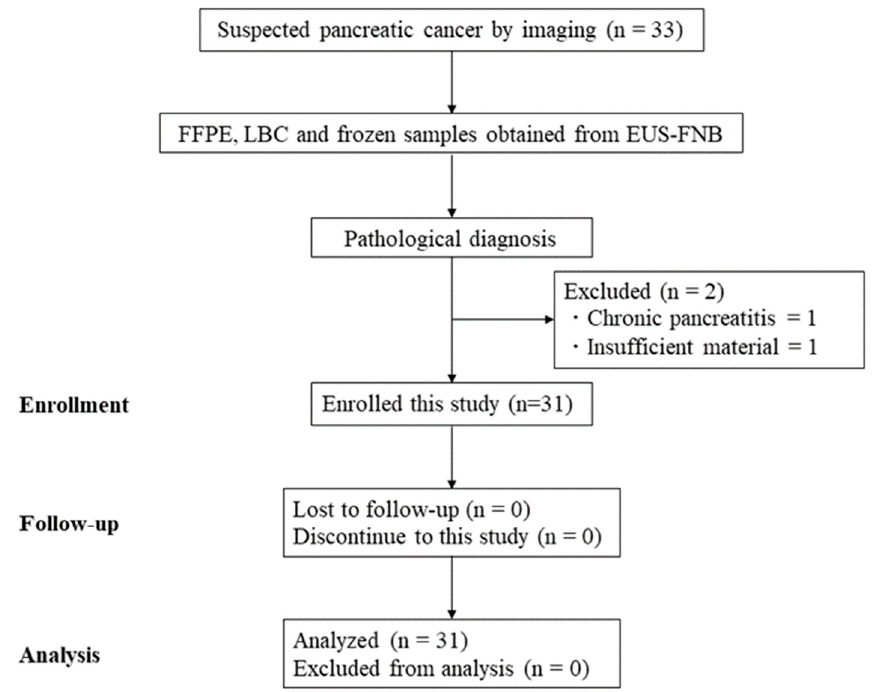
Figure 1. Flow diagram of patient selection. CT, computed tomography; FFPE, formalin-fixed paraffin-embedded; LBC, liquid-based cytology; EUS-FNB, endoscopic ultrasound–guided fine-needle biopsy.